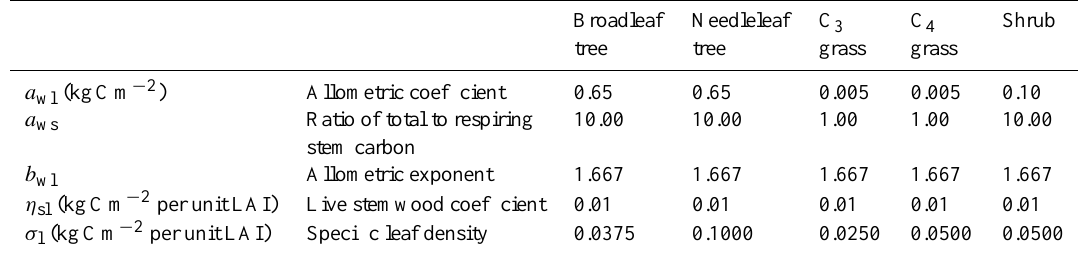
Table 7. Default values of PFT-specific parameters for allometry and vegetation carbon. Broadleaf Needleleaf C 3 C 4 Shrub tree tree grass grass Allometric coefficient 0.65 Ratio of total to respiring